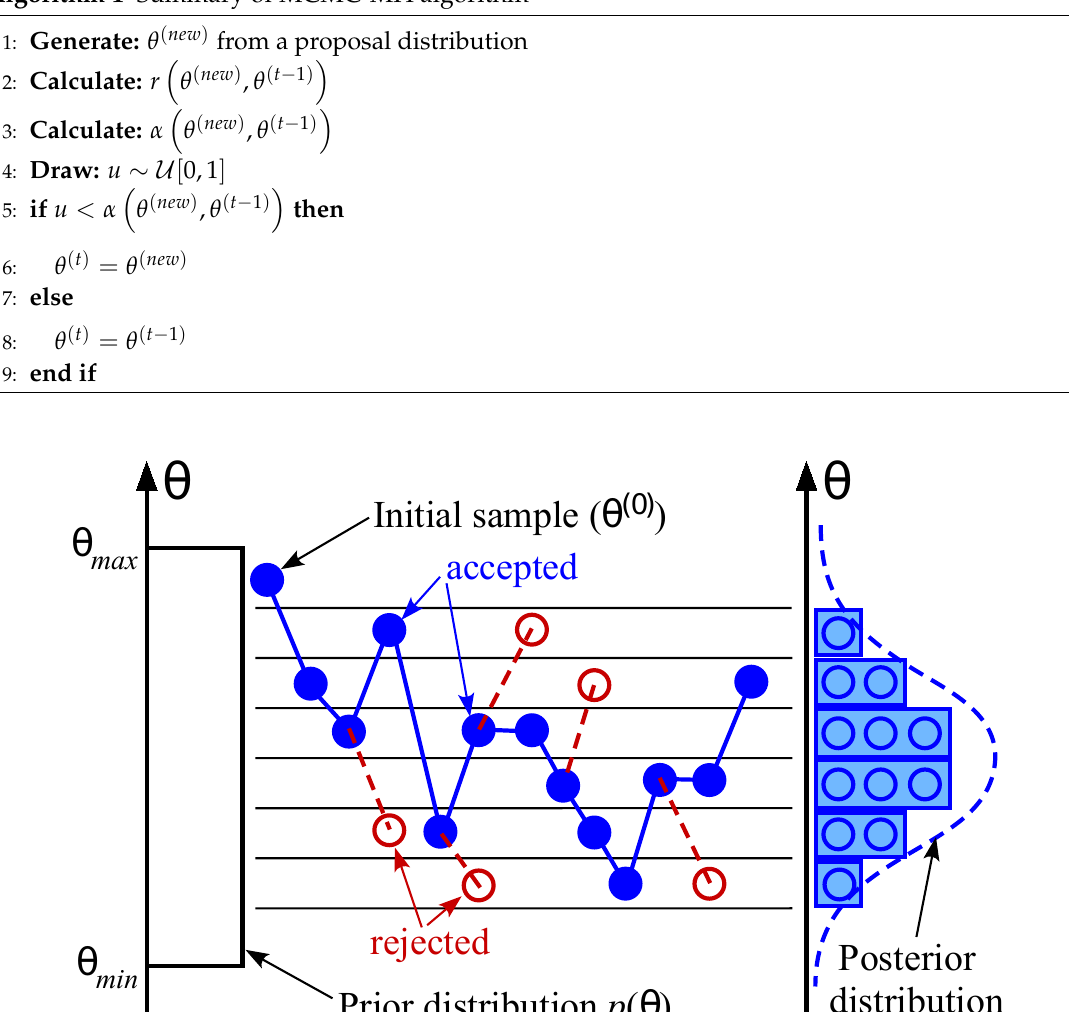
Algorithm 1 Summary of MCMC-MH algorithm